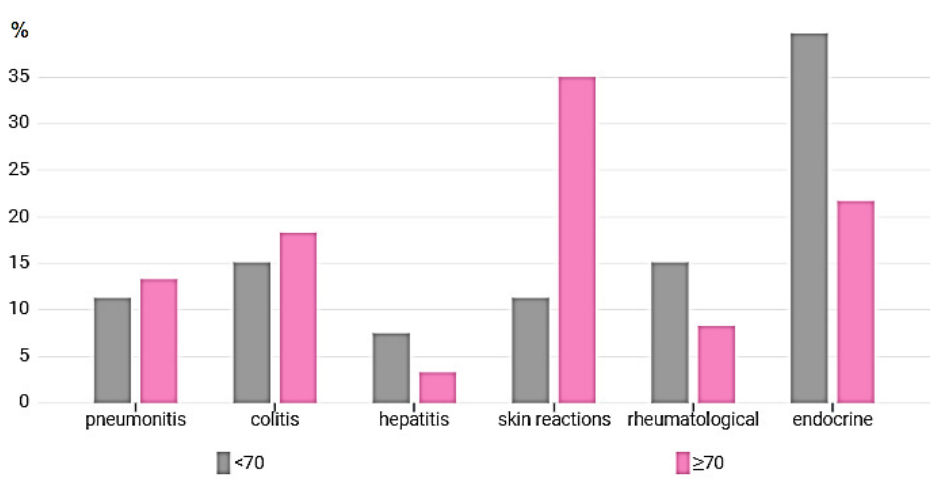
Figure 1. Graphic representation of the distribution of toxicities divided by age groups and type of irAE.